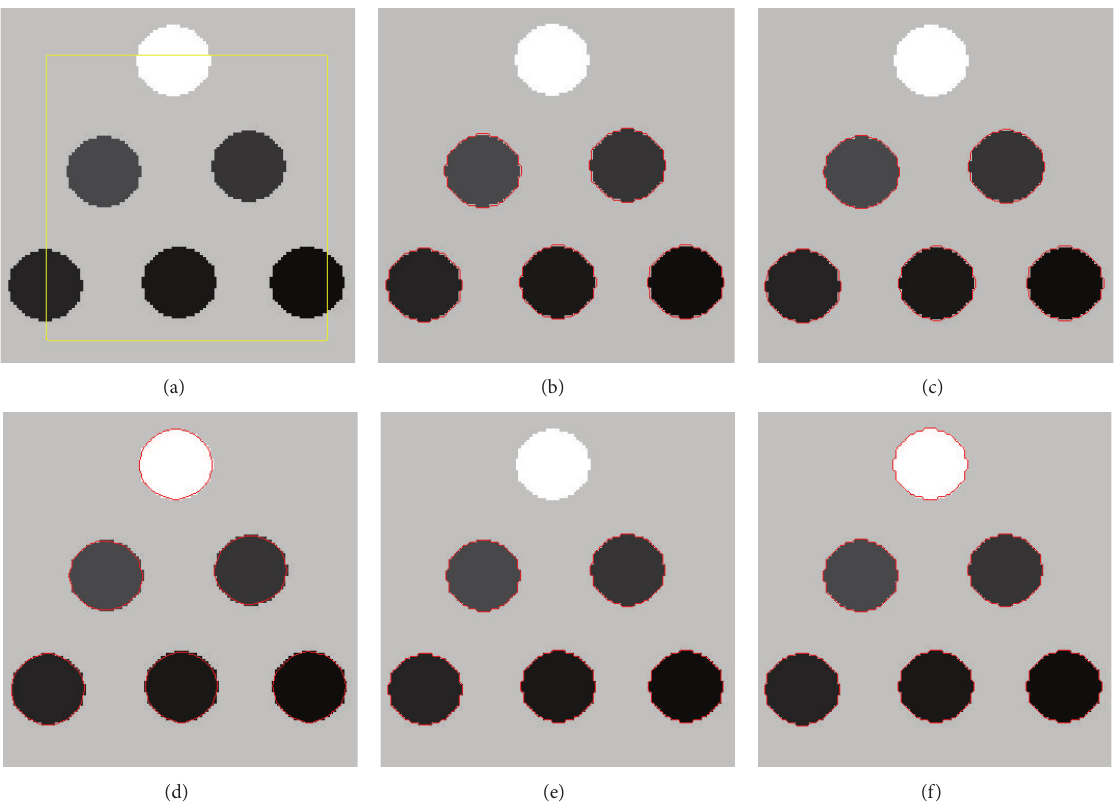
Figure 10: Segmentation results on the synthetic image: (a) the initial contour, (b) CV result, (c) GACV result, (d) DRLSE result, (e) FAC result, and (f) LFAC